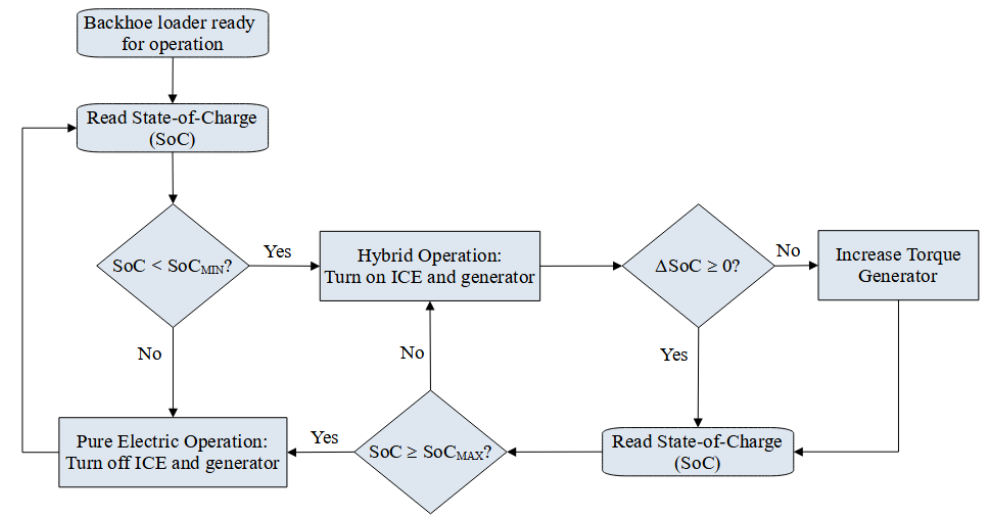
Figure 5. Energy management strategy